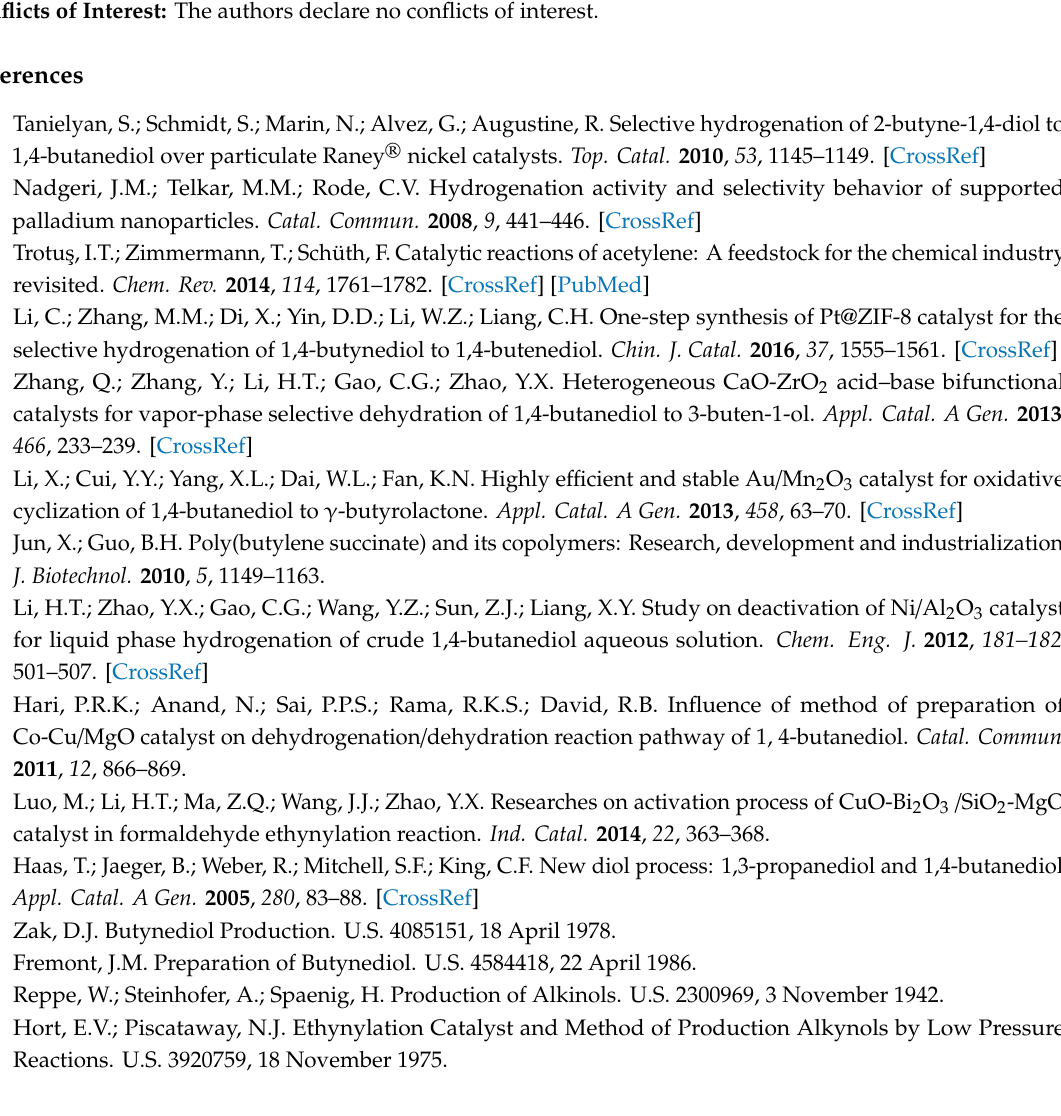
Figure S1: XPS spectra (a) and X-ray excited Auger electron spectroscopy (XAES) spectra (b) of the catalysts after reaction after